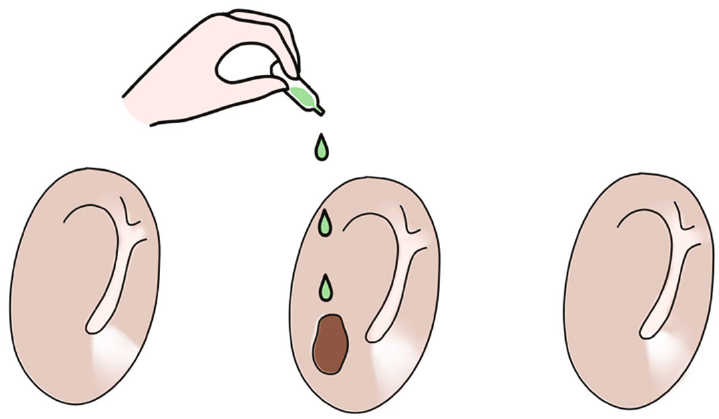
Figure 2: Diagram of EGF or FGF2 in repair of acute